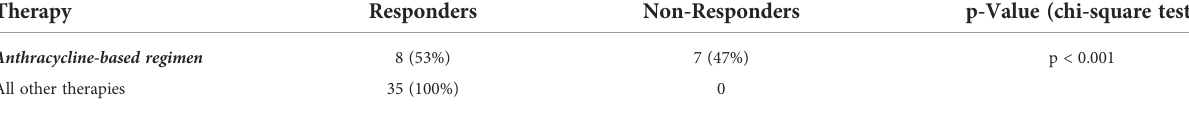
TABLE 3 Responder rates in anthracycline-based regimen vs all other therapies.